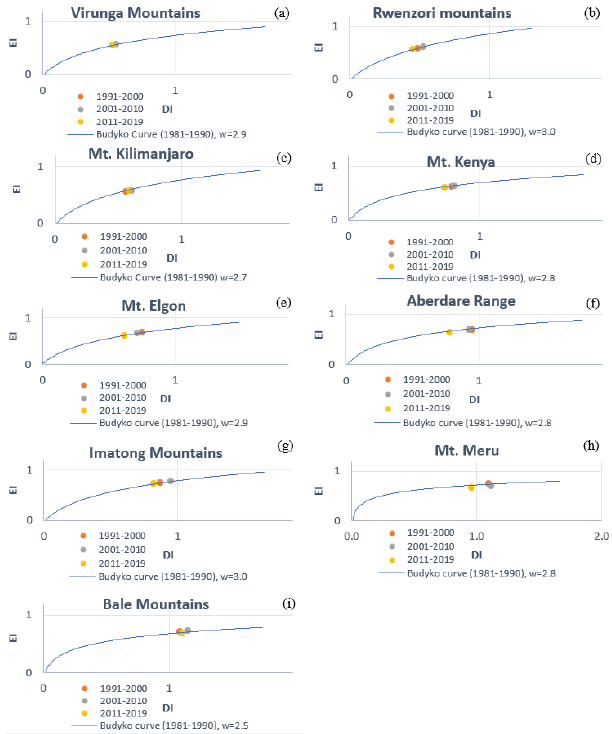
Figure A5. Graphical representation of the baseline Budyko curve (estimated for 1981–1990) and the trends of water towers in the different